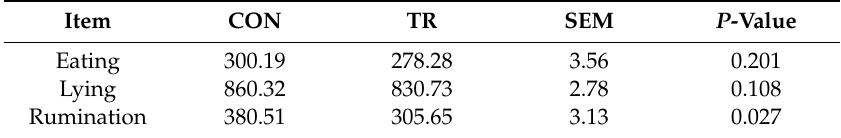
Table 3. Average durations of daily feeding behavior (in minutes) observed in CON 1 and TR 2 groups.